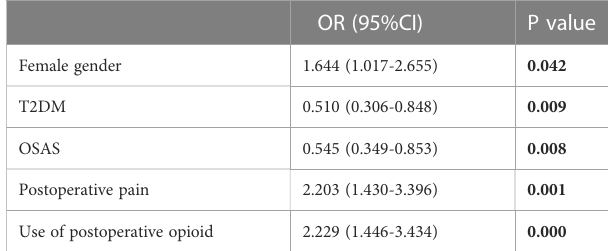
TABLE 5 Odds ratio (OR) and 95% con fi dence intervals (CI) of risk factors for PONV after LSG (after